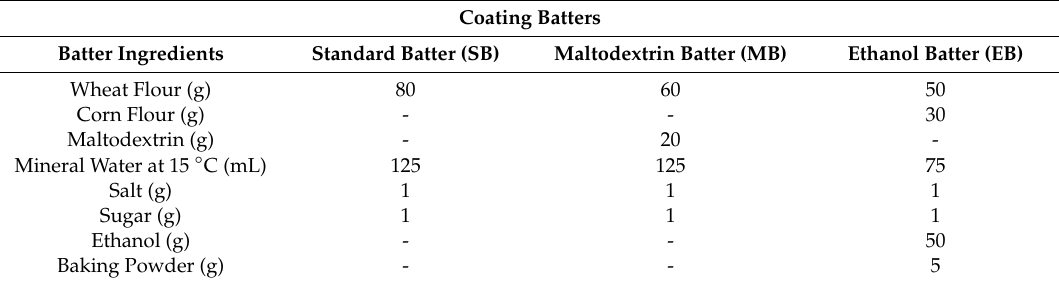
Table 1. Comparison of the coating batter